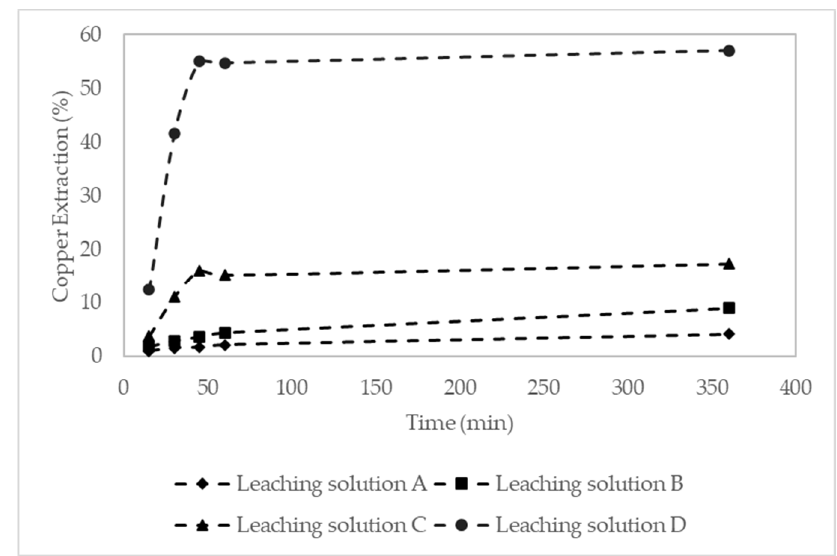
Figure 1. Effect of hydrogen peroxide on copper extraction.